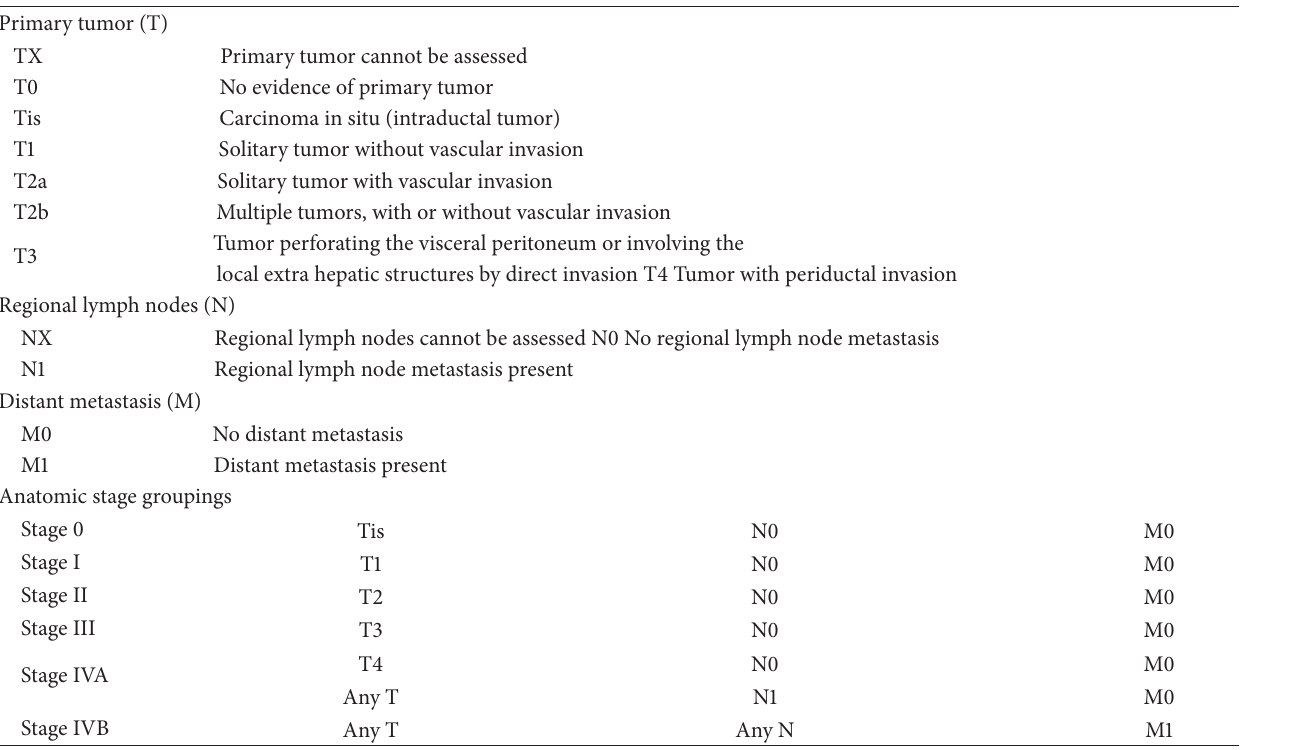
Table 2: American Joint Committee on Cancer (AJCC). TNM Staging for Intrahepatic Bile Duct Tumors (7th edition,